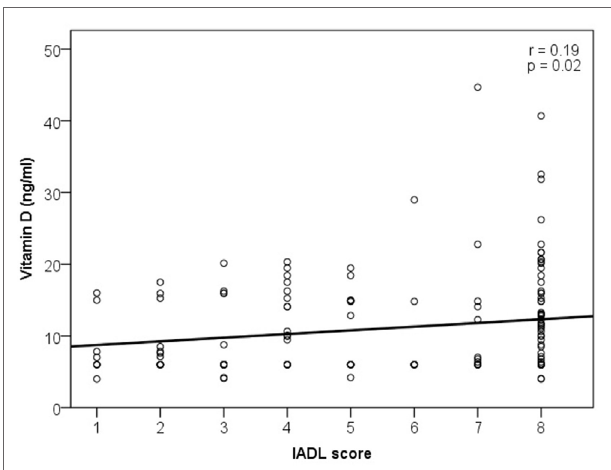
FigUre 2 | Association of vitamin D level and instrumental activities of daily living